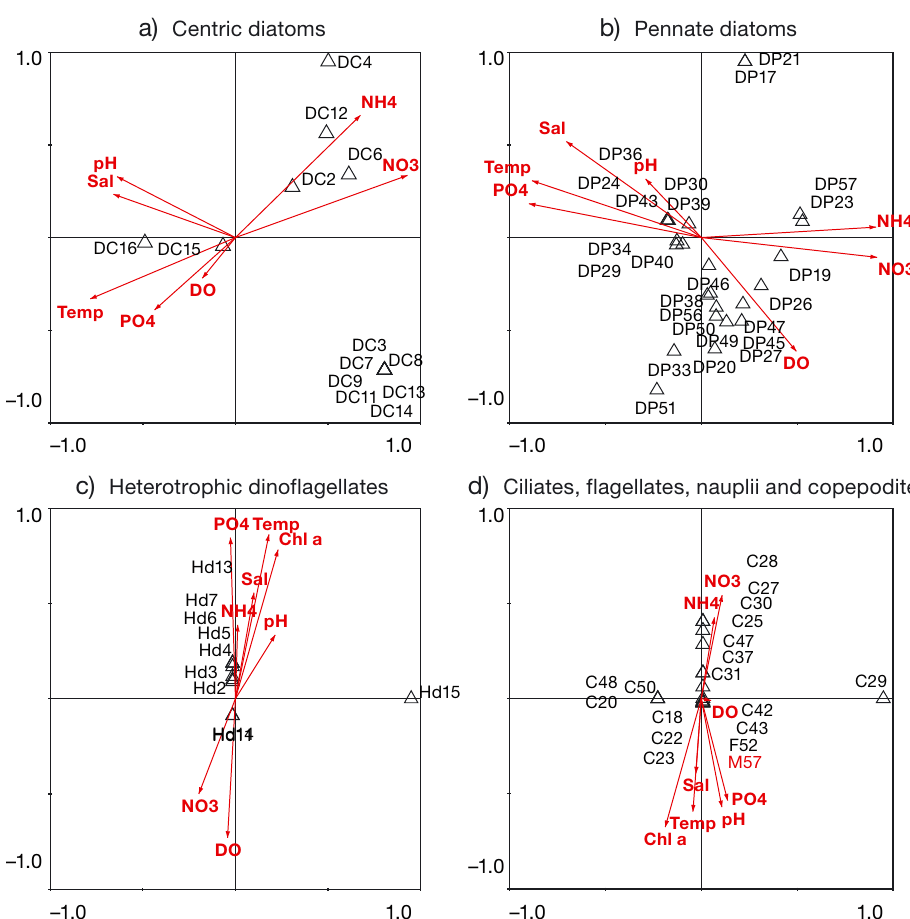
Fig. 6. Canonical correspondence analysis ordination diagram of water quality parameters with species/ genus/ groups of (a,b) phytoplankton and (c,d) microzooplankton during the culture of Litopenaeus vannamei. Results are for axis 1 (horizontal) and axis 2 (vertical); arrows represent forward-selected water quality variables (Temp: temperature; Sal: salinity; NH 4 : ammonium; NO 3 : nitrate; PO 4 , phosphate; Chl a : chlorophyll a ; DO: dissolved oxygen). Arrow length indicates the strength of that variable in explaining the species distribution during the culture; arrow direction: approximate correlation to the ordination axes.